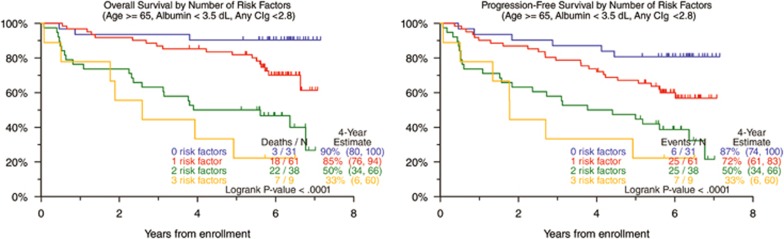
Kaplan–Meier plots of OS and PFS in TT3b as defined by the multivariate survival analysis model (GEP variables excluded).